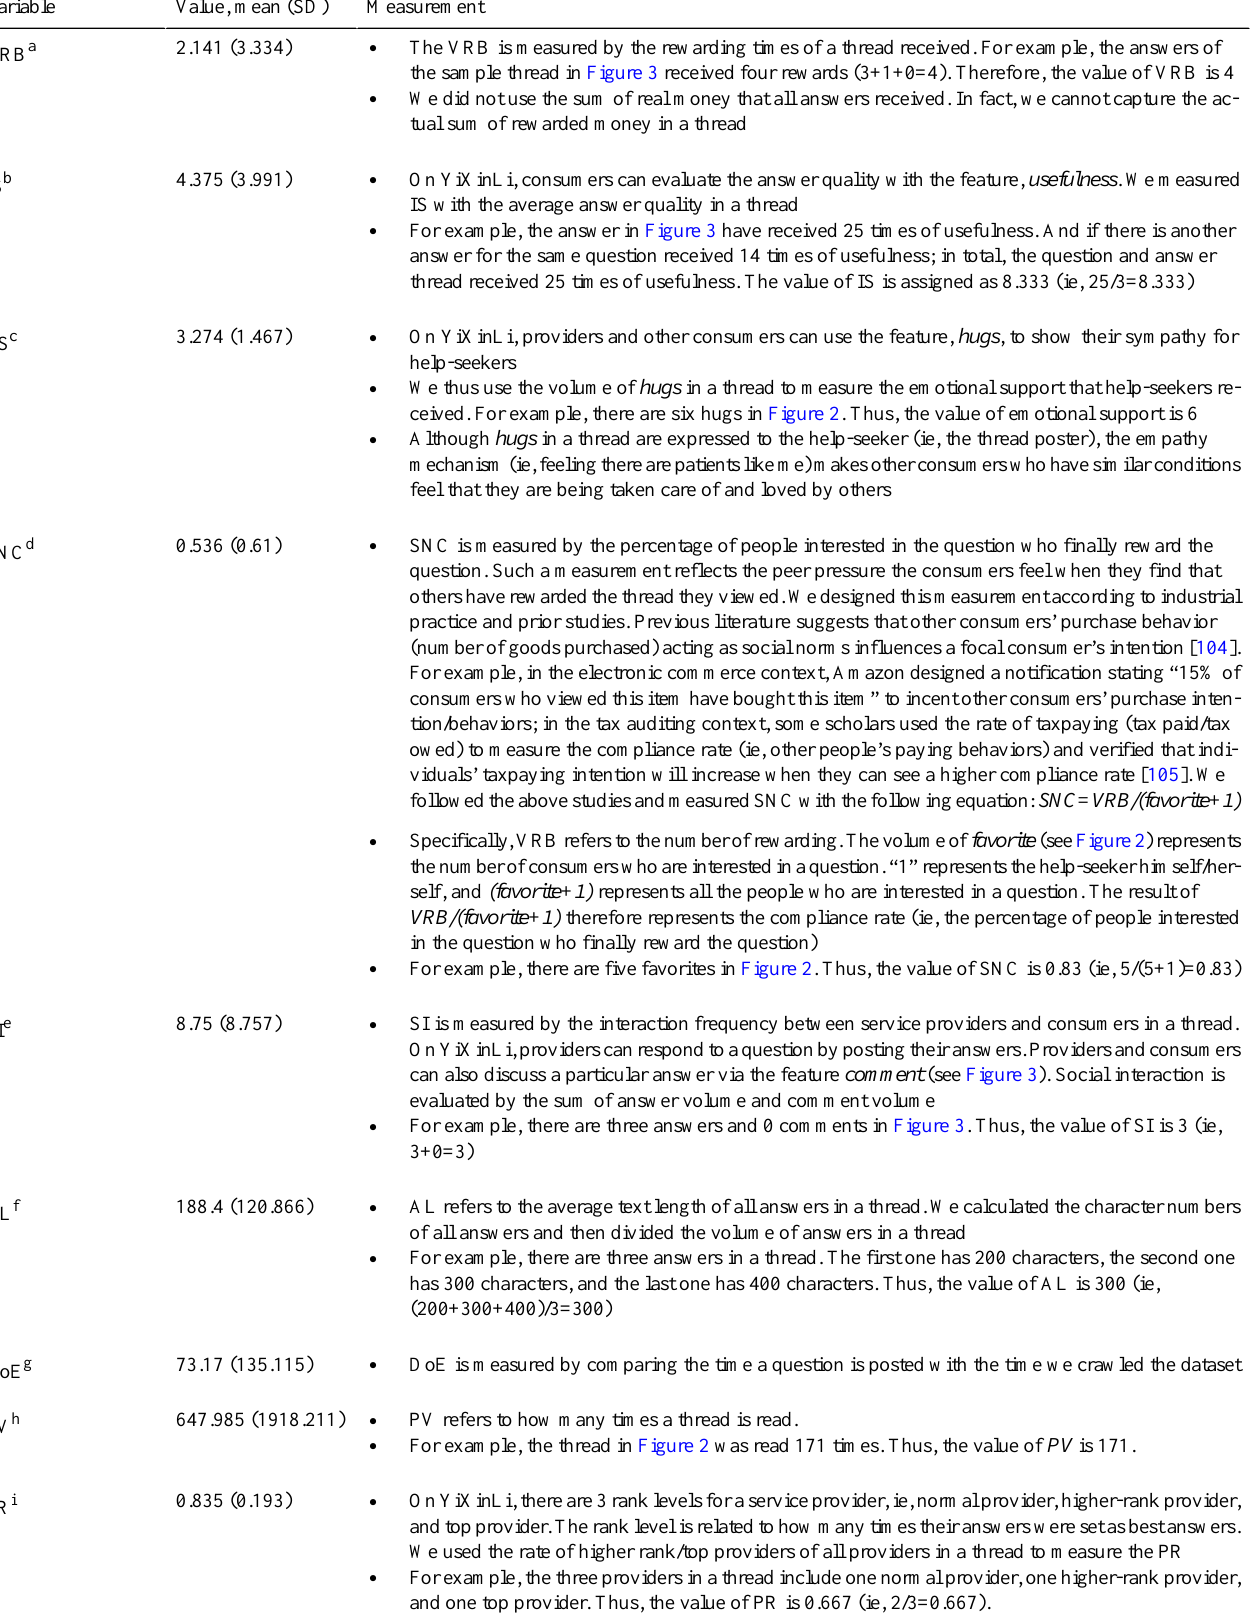
Table 2. Variables and measurement. MeasurementValue, mean